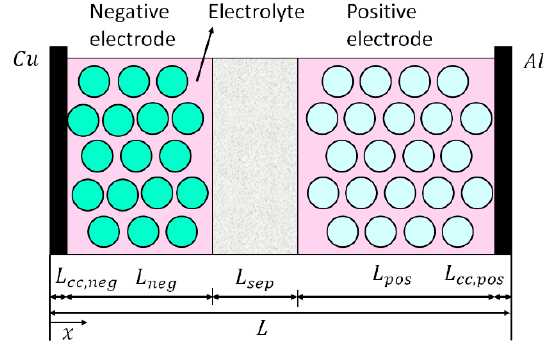
Figure 1. Schematic of the 1D geometry of a single pair.